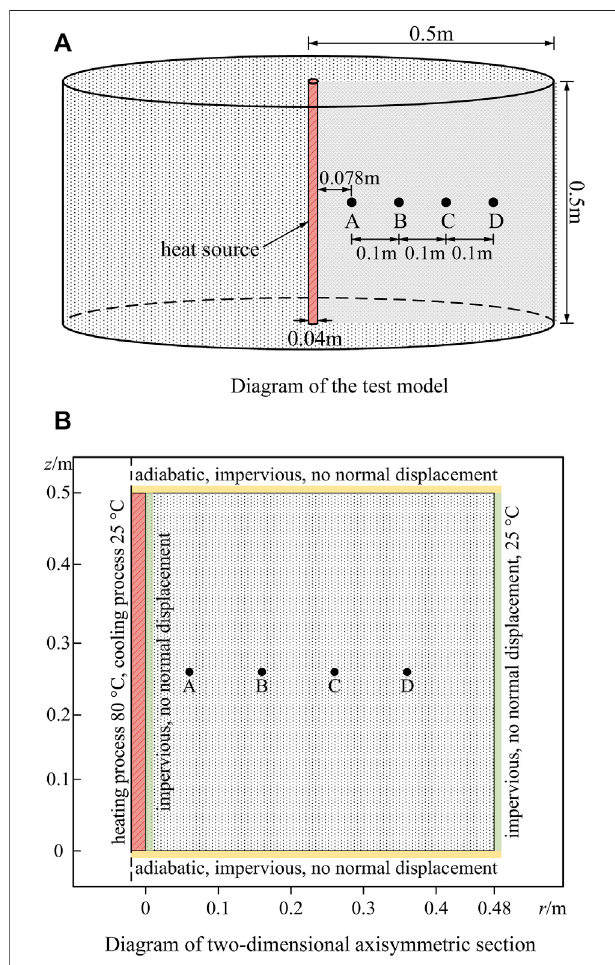
FIGURE 5 | Diagram of the calculation